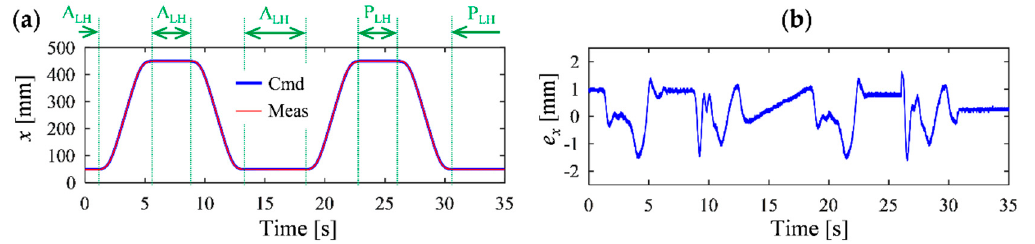
Figure 9. ( a ) Commanded and measured piston position; ( b ) Position error.